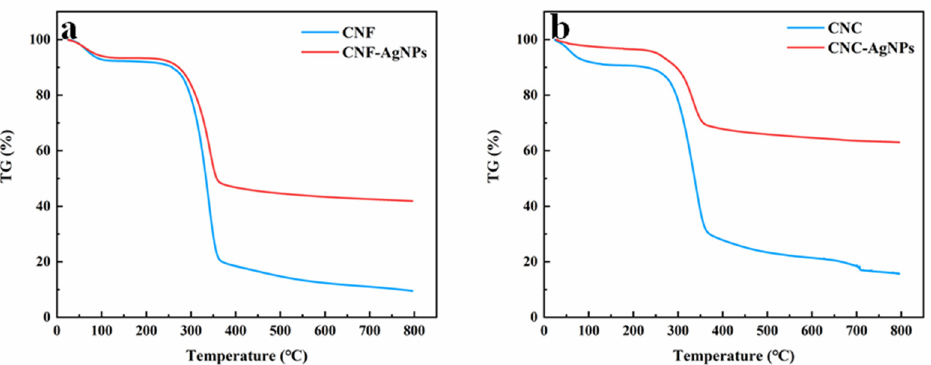
Figure 5. TG graphs of the nanocellulose and NC-AgNPs. ( a ) TG graphs of the CNF and CNF-AgNPs, ( b ) TG graphs of the CNC and CNC-AgNPs.